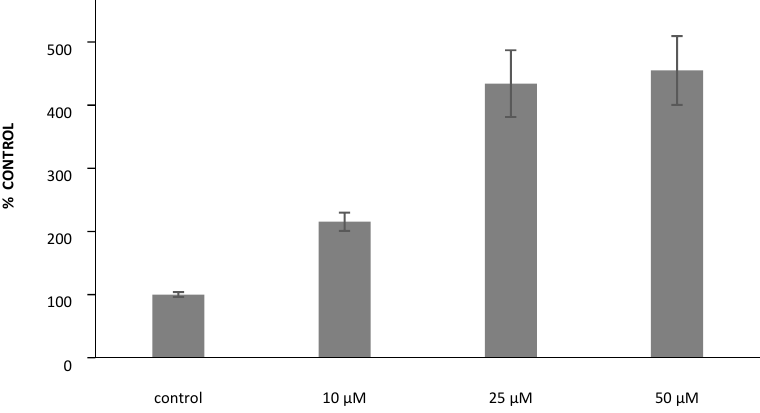
Figure 3. ROS production in A2780 cells after 120 min of treatment with ( R )-5a at indicated concentrations. ( n = 3–5, mean ± standard deviation).